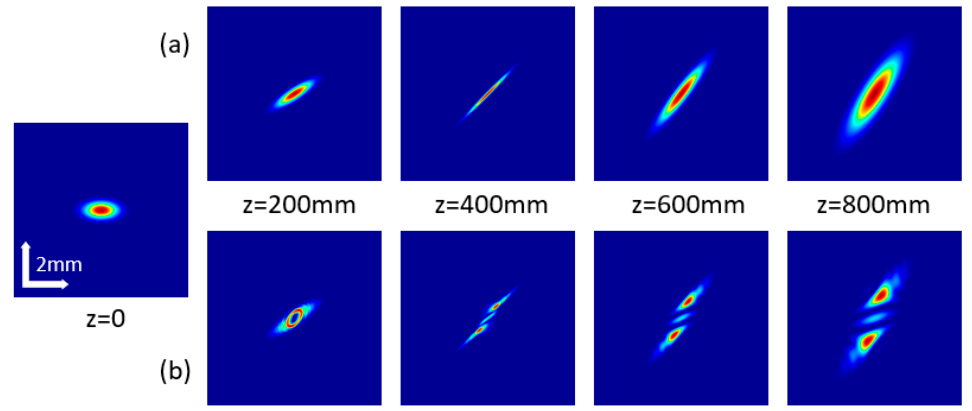
Figure 5. The spectral density of the ( a ) anisotropic Gaussian beam and ( b ) vortex beam ( m = 2) under the effect of the twisting phase during propagation.